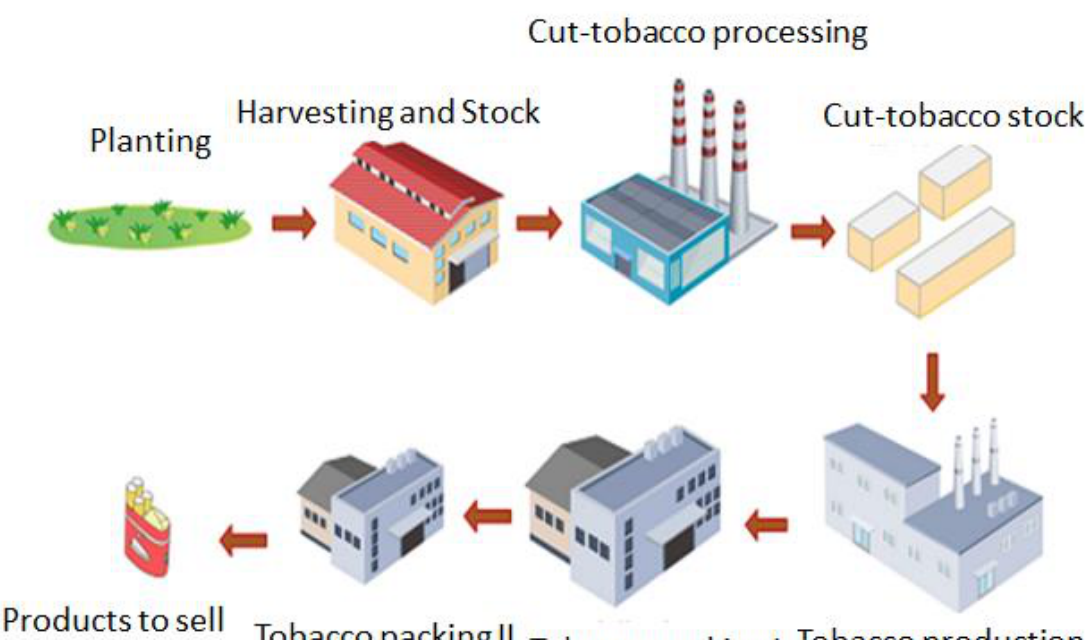
Figure 1. Life-cycle of the tobacco industry.